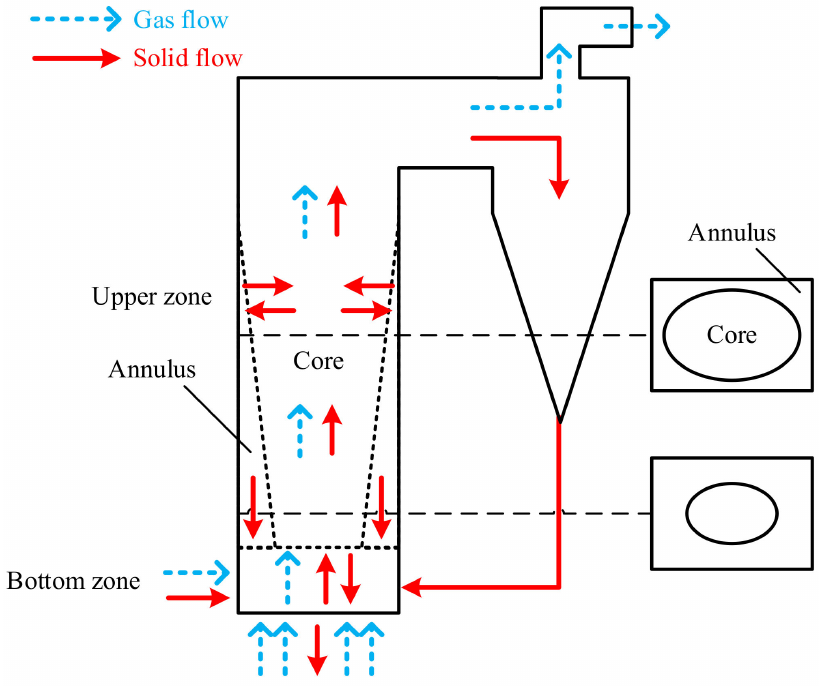
Figure 5. Diagram of “core-annulus” in CFB